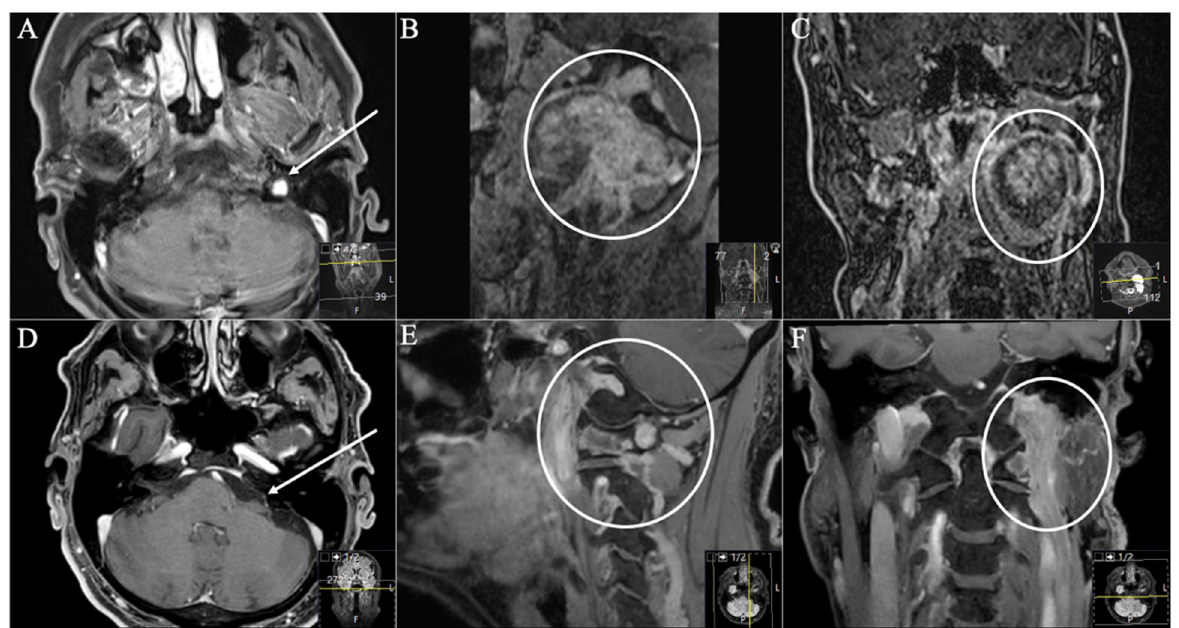
Figure 5. A 46-year-old male patient presented with headache, hoarseness, dysphagia, and extinguished gag reflex. ( A ) Preoperative axial (arrow), ( B ) sagittal (circle), and ( C ) coronal (circle) T1-weighted gadolinium-enhanced MRI, showing a massive space-occupying extracranial jugular foramen schwannoma with extension into the JF (Samii Type C). ( D ) Postoperative axial, ( E ) sagittal, and ( F ) coronal MRI control, indicating complete resection through an anterolateral ELITE approach. Postoperatively, no new deficits occurred, and the patient recovered from the hoarseness and extinguished gag reflex. Dysphagia remained but improved during follow-up as well.